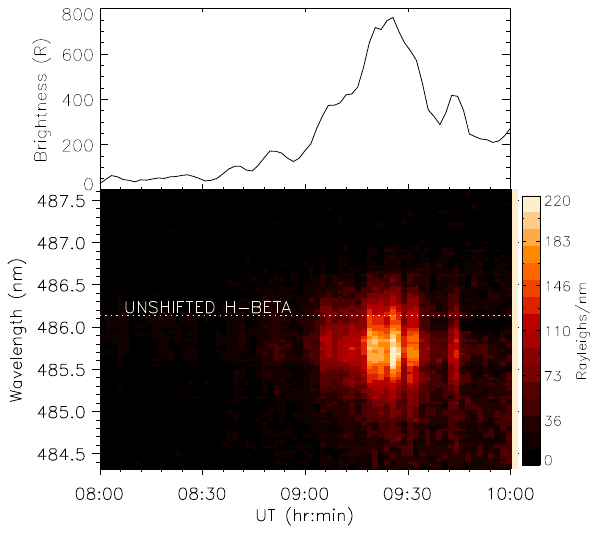
Fig. 11. (top) Changes in peak H β intensity. (bottom) Changes in H β profile